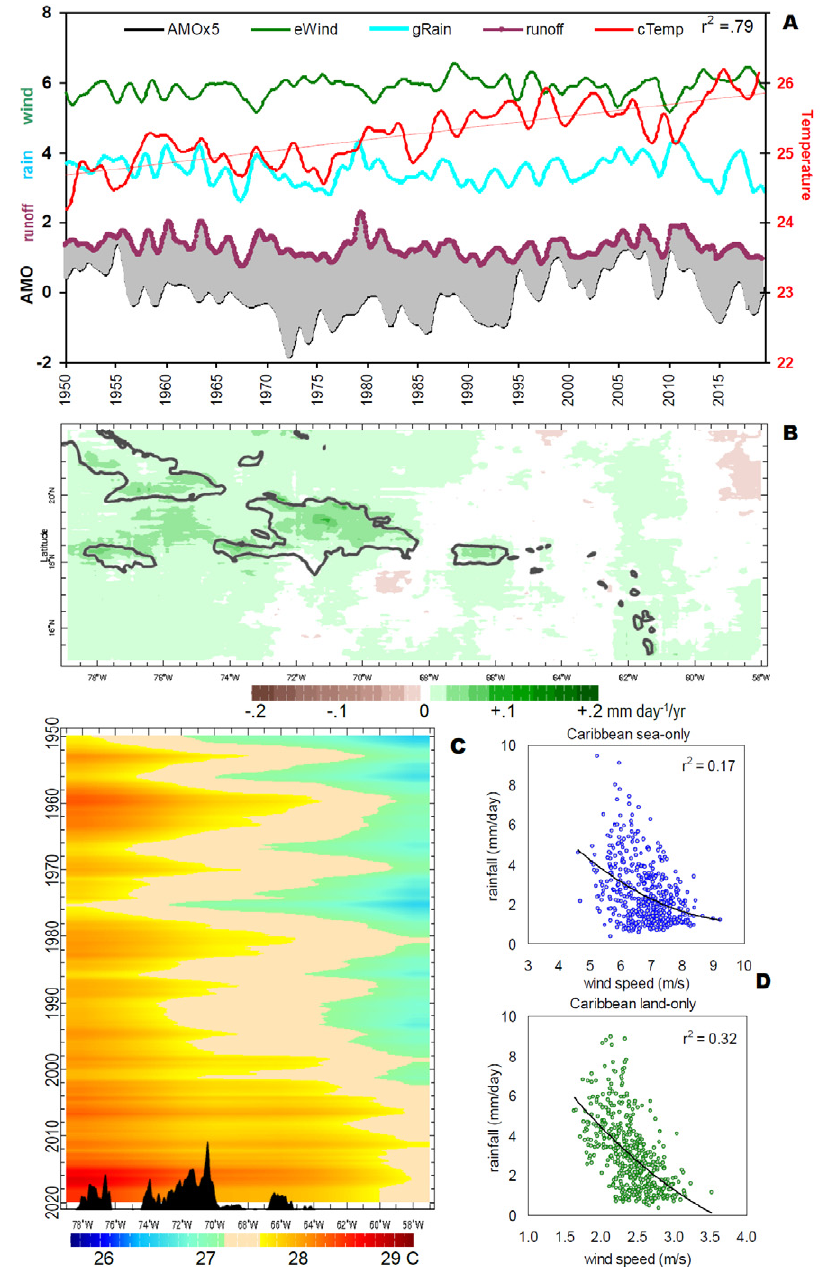
Figure 6. ( a ) Long-term records of 18-month filtered Caribbean climate; shading (lower) highlights weak AMO influence on runoff; trends are significant for air temperature (cTemp). ( b ) CHIRP rain trend analysis 1981–2019 (mm day − 1 / yr). ( c ) NOAA SST hovmoller plot avg 15–22 ◦ N highlighting eastward expansion of the Atlantic warm pool since 1950, with topography lower. ( d ) Temporal scatterplots of monthly Caribbean ECMWF5 wind speed vs rainfall for sea and land 1979–2019 (N =